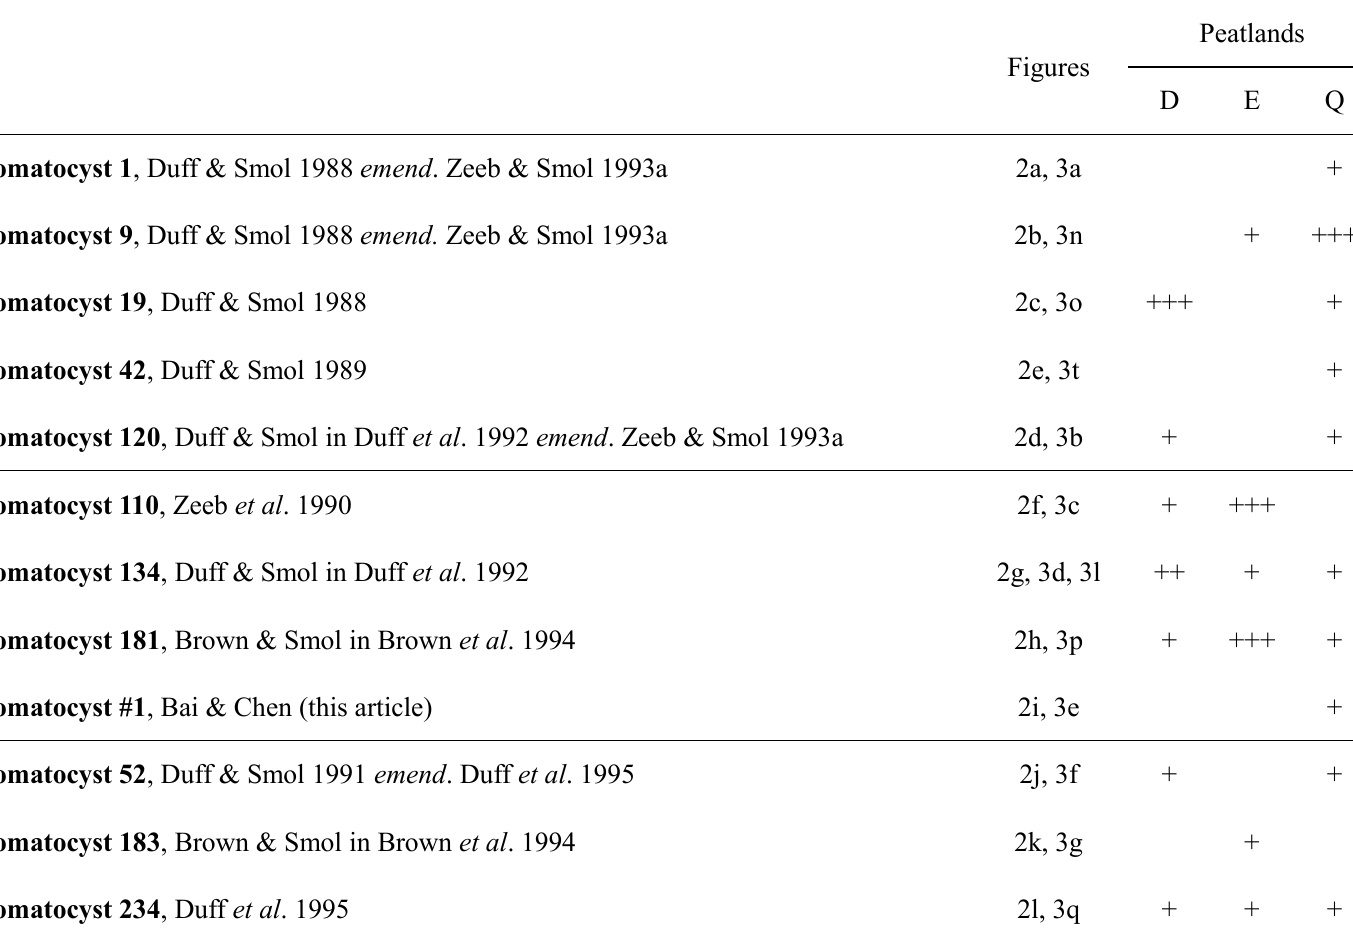
Table 2. List of previously identified and newly observed stomatocysts in Dajiuhu (D), Erxianyan (E) and Qianzimeishan (Q) peatlands and their frequencies (+ rare; ++ moderate; +++